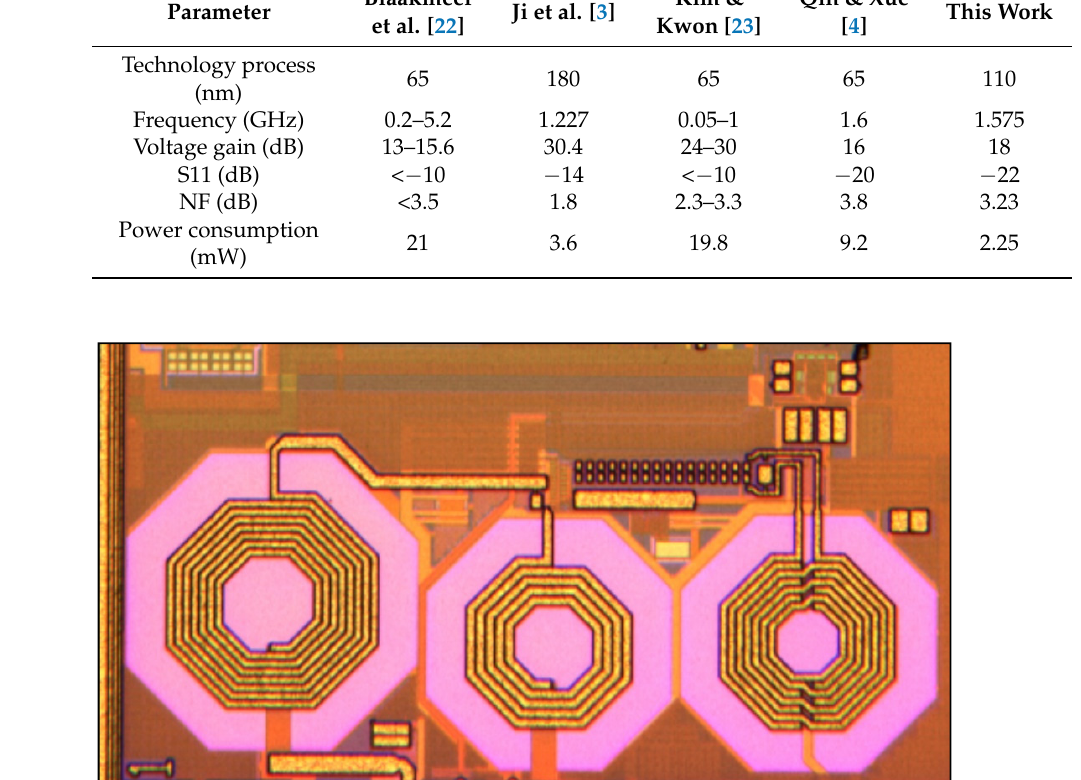
Table 1. Comparison of results for baluns from the literature.